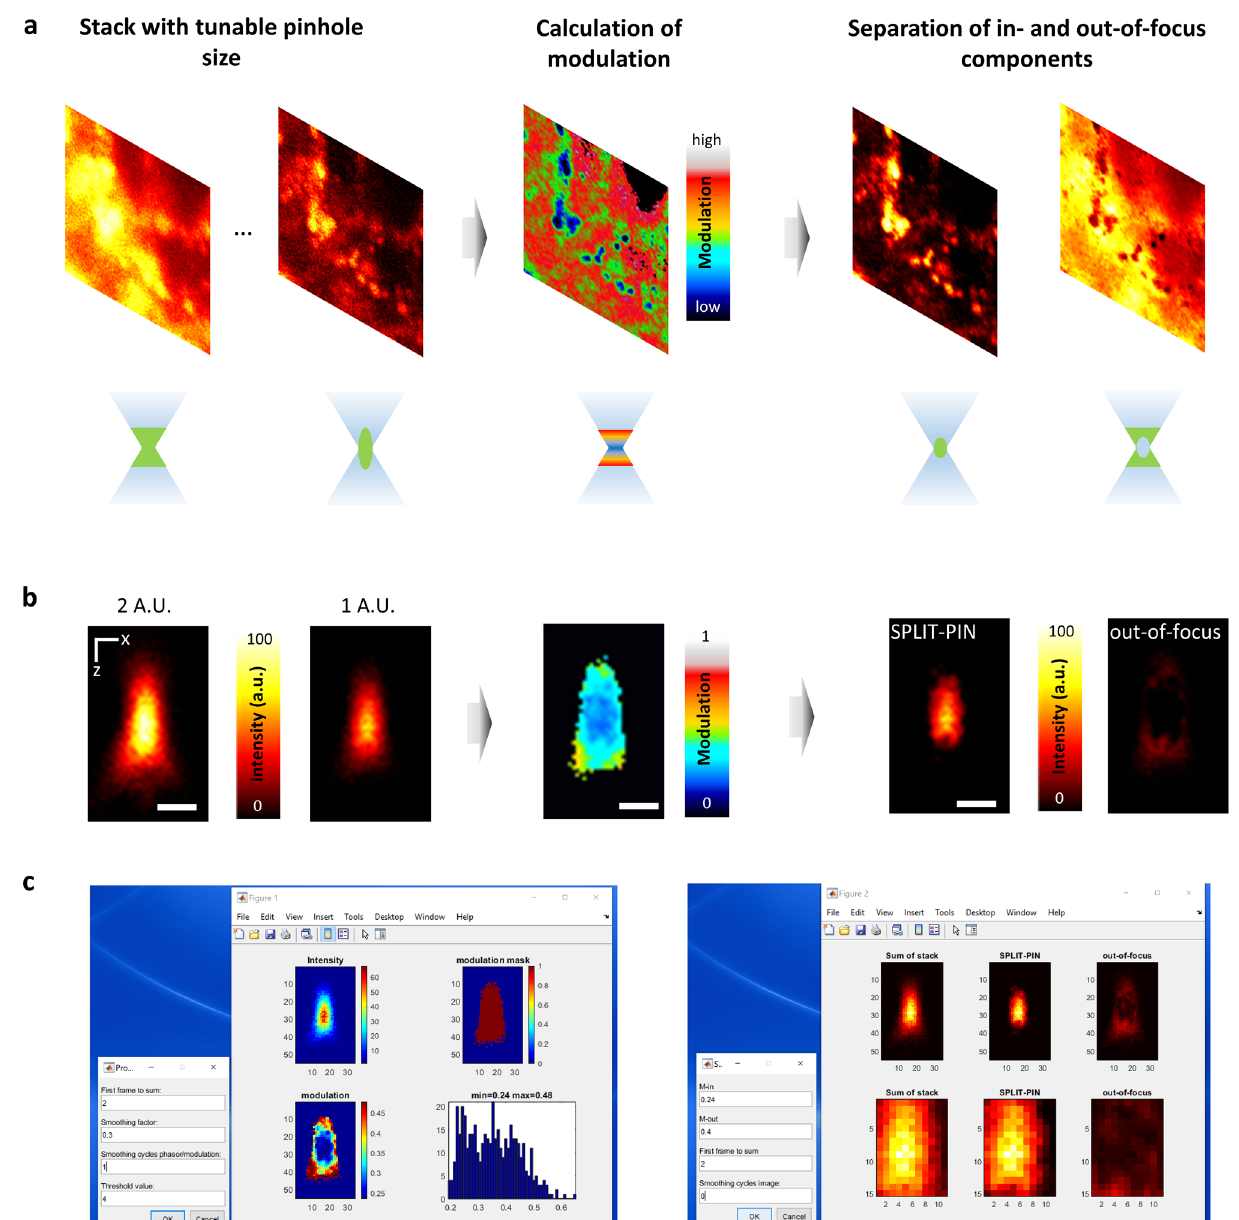
Figure 1. SPLIT-PIN algorithm. ( a ) (top) Workflow of the SPLIT-PIN approach: a series of images is acquired with a tunable pinhole size; a modulation image is calculated; the in-focus intensity is separated from the out- of-focus intensity. (bottom) Schematic representation of the effective detection volume corresponding to each of the image shown above. ( b ) Application of SPLIT-PIN to a series of confocal xz images of 200-nm fluorescent spheres acquired at the indicated pinhole size (A.U., Airy Units). Scale bar 500 nm. ( c ) Screenshots of the two main interactive menus in the user-friendly script, corresponding to the calculation of the modulation image (left) and to the generation of the SPLIT-PIN image (right),